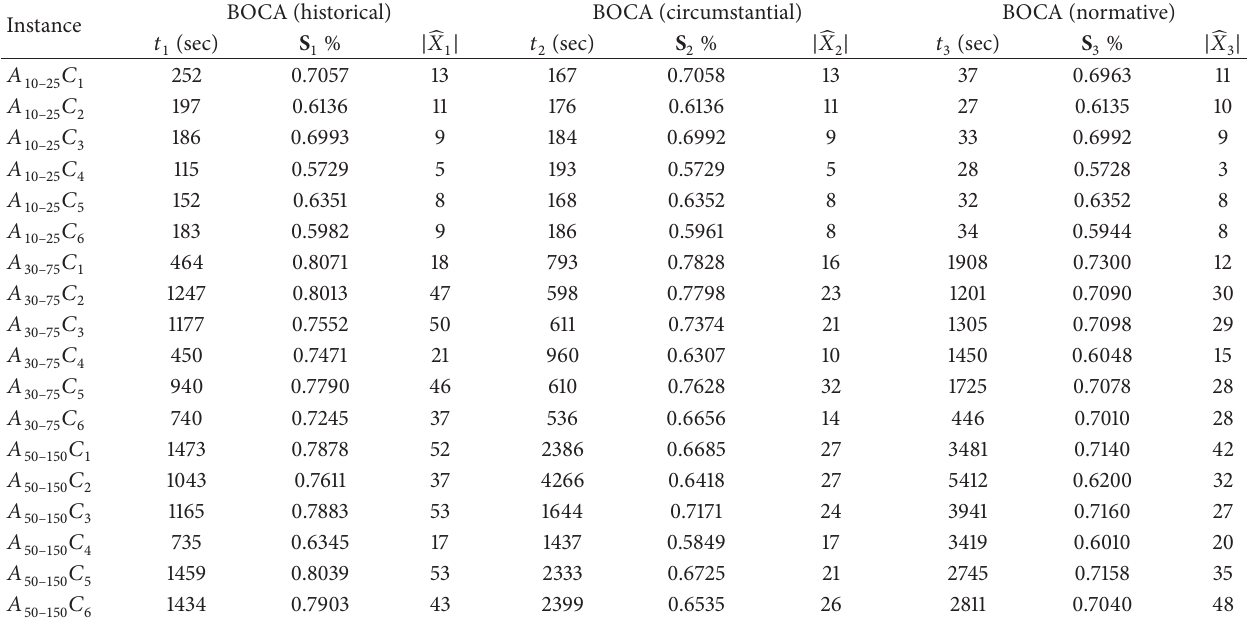
Table 1: Results obtained by the BOCA implementations for instance of class 𝐴 .